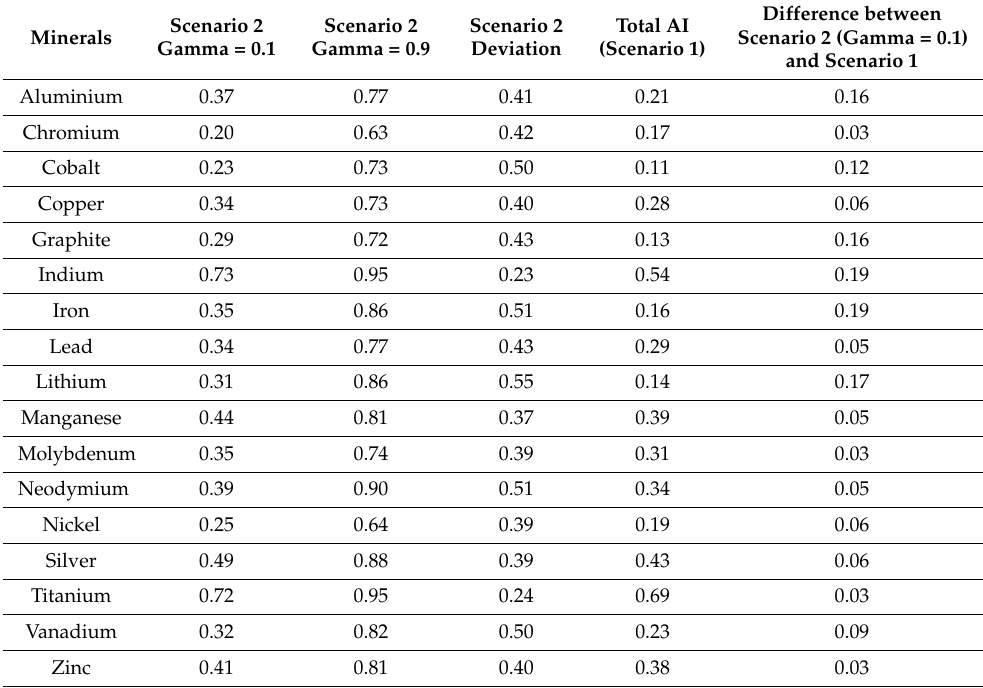
Table 8. Comparison of results of Scenario 1 and Scenario